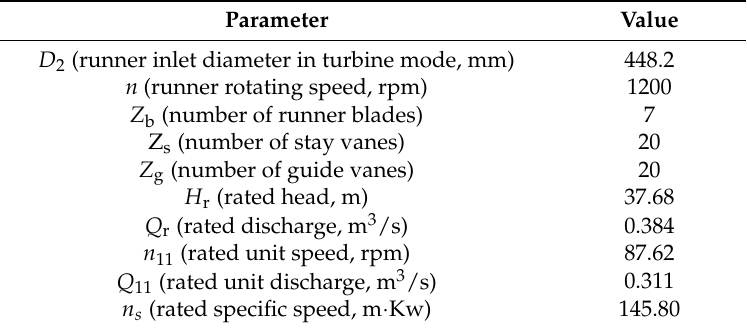
Table 1. Parameters of pump-turbine model in turbine mode.